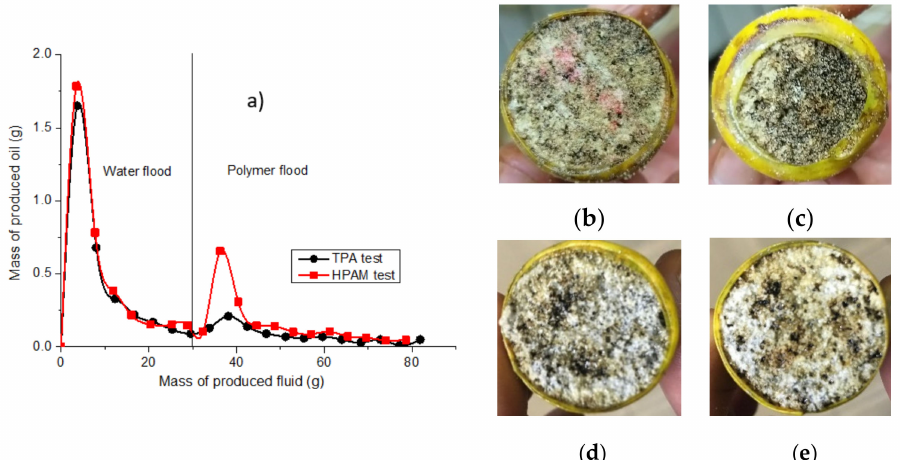
Figure 10. ( a ) Mass of oil produced during water and polymer injections in the aerated concrete cores; core inlet ( b ) and outlet ( c ) after testing with TPA; core inlet ( d ) and outlet ( e ) after testing with HPAM.